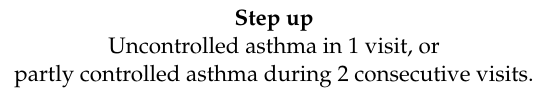
Table 1. Criteria for medication titration (step up, no change, or step